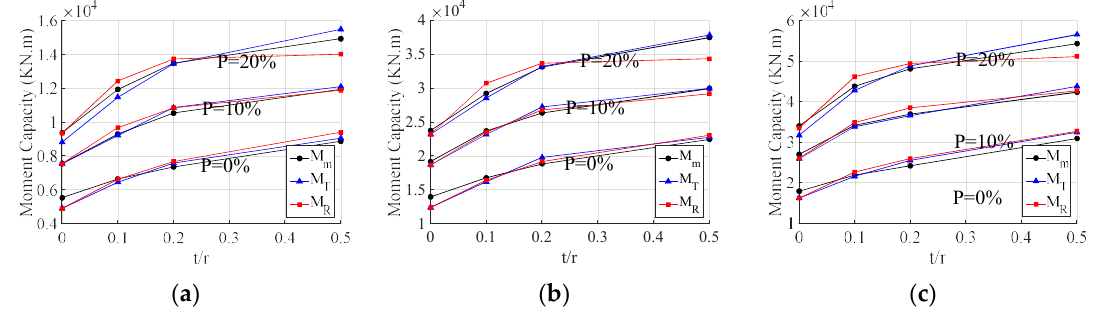
Figure 3. Moment capacity comparison for ( a ) set 1, r = 686 mm ( b ) set 2, r = 914 mm ( c ) set 3, r = 1067 mm.